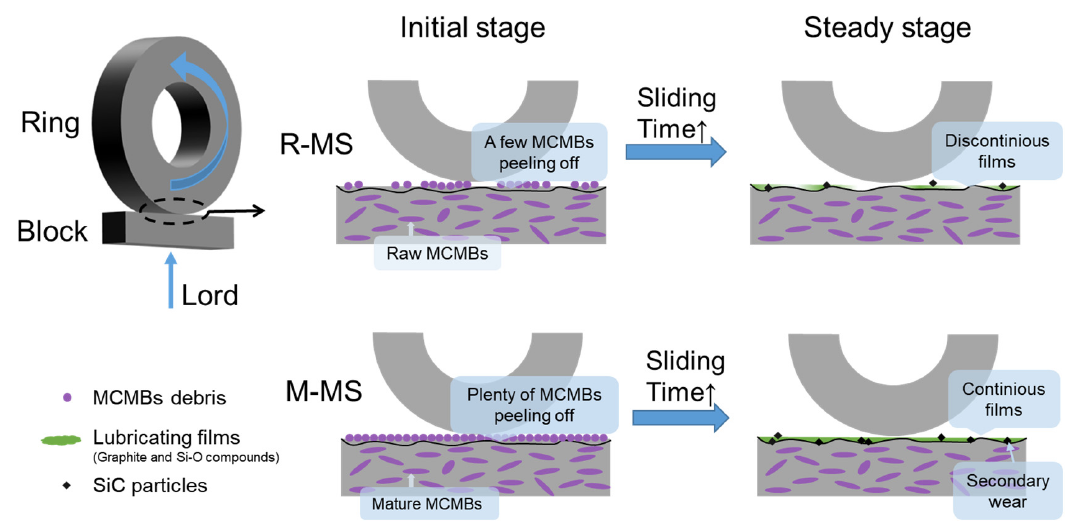
Figure 9. Wear mechanism of MCMB-SiC composites.